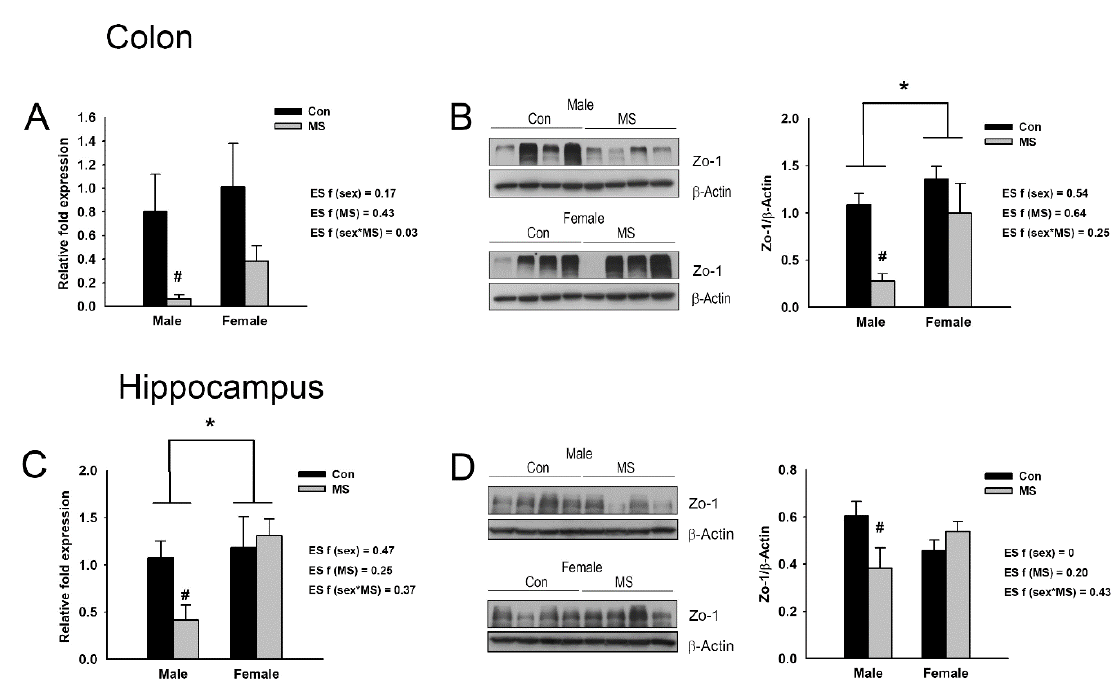
Figure 5. Effect of maternal separation (MS) on the expression levels of tight junction protein Zonula occludens-1 (Zo-1) and gene encoding it. ( A ) The mRNA and ( B ) protein expression of Zo-1 in the distal colon of male and female MS rats. ( C ) The mRNA and ( D ) protein expression of Zo-1 in the hippocampus of male and female MS rats. The mRNA and protein expression levels are normalized against Gapdh and β -Actin, respectively. Data are mean ± SEM. A two-way ANOVA test, * p < 0.05 on male vs. female; # p < 0.05 on control vs. MS within each sex. Effect size (ES) f was calculated using G*Power 3. n = 6–10 per group.